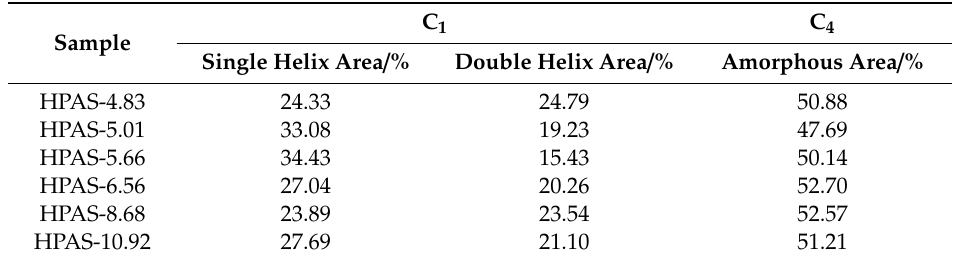
Table 3. Proportions of single helix, double helices, and amorphous structures of HPAS-CA films with di ff erent citric acid